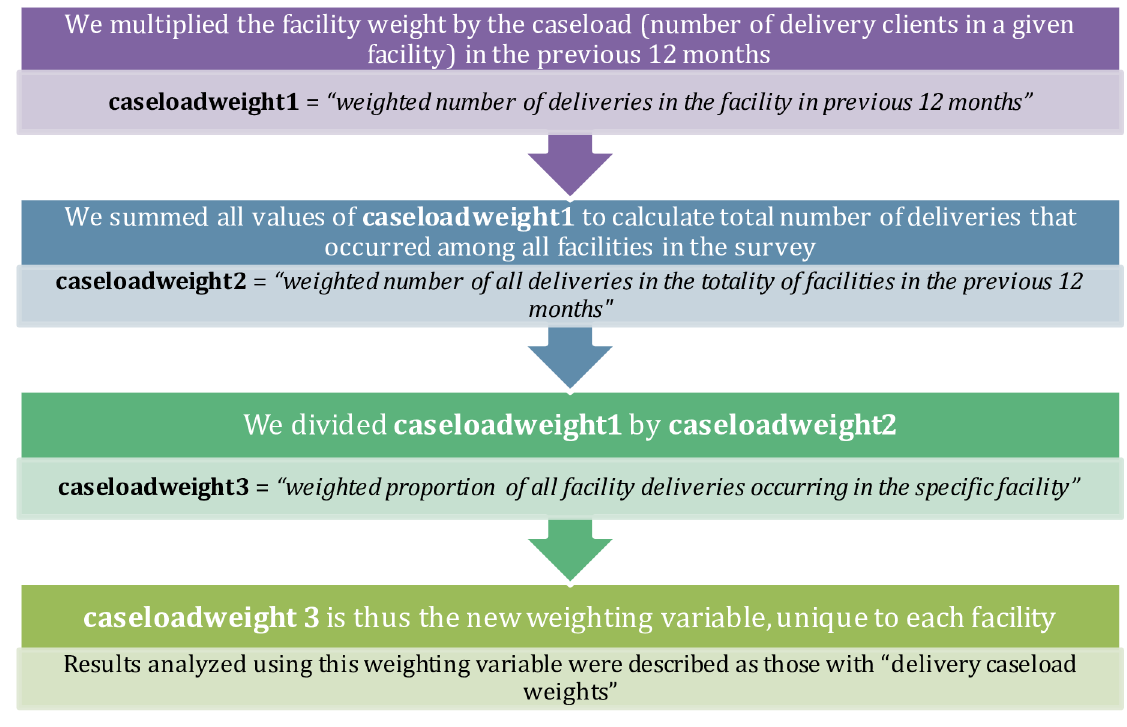
Fig 2. Delivery caseload weight calculation procedure for each facility. Each step in the chart signifiesa separate mathematical step, ultimatelyshowinghow one can incorporatedeliverycaseloadinto survey weight values. A worked exampleis found in S1